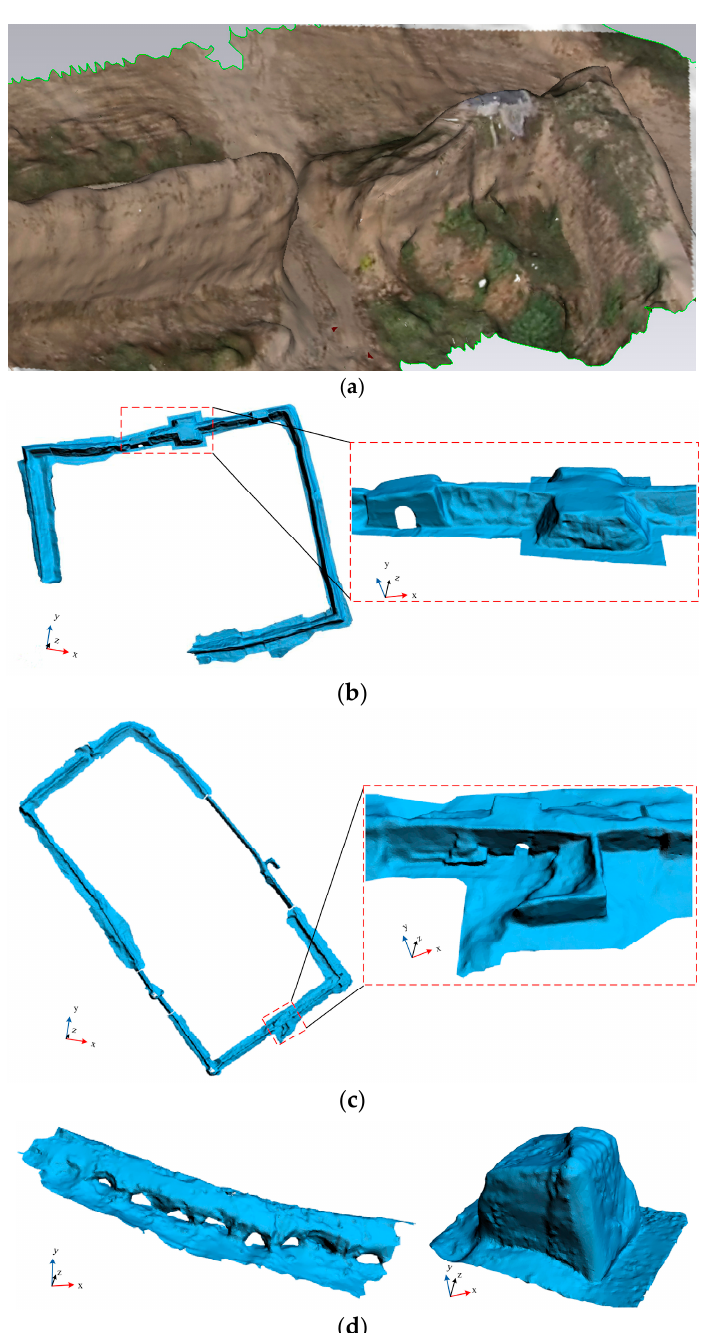
Figure 12. 3D models of the Great Wall heritage site in typical areas, ( a ) a single textured segment in Zhenbei Tai with a breach (total length ~32 m); ( b ) Zhenbei Tai without texture for a better view of the geometric structure (total length ~530 m); ( c ) Jianan Bao (total length ~1066 m); ( d ) left: Erlou Cun (total length ~58 m), right: Shiba Dun Cun (height ~12 m). Table 3. Simplification for the 3D models of the study areas.